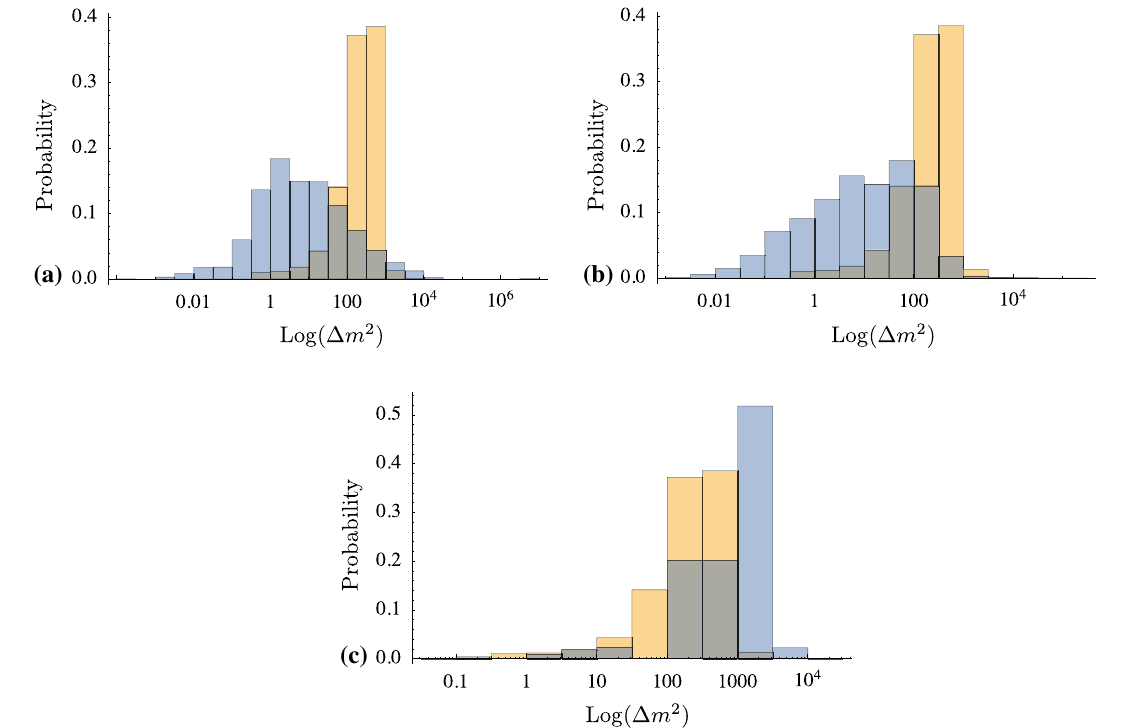
Fig. 9 Probability histograms for the scale separation between the heaviest and the lightest mode. Different histograms correspond to the case when a given modulus is the lightest: a Kähler (T), b complex